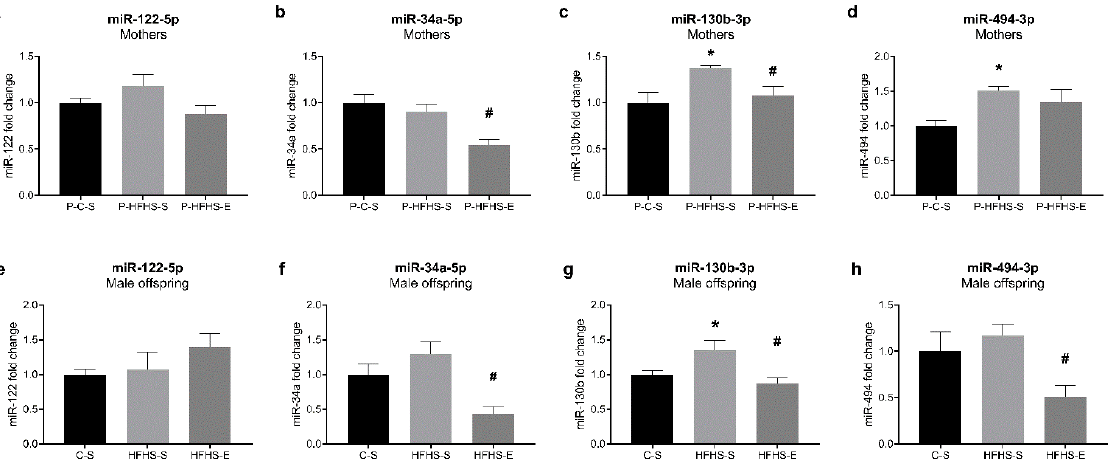
Figure 7. Effects of maternal HFHS and GE on the micro-RNA expression in maternal livers: ( a ) relative expression of miR-122, ( b ) relative expression of miR-34a, ( c ) relative expression of miR-130b, ( d ) relative expression of miR-494; and in offspring: ( e ) relative expression of miR-122, ( f ) relative expression of miR-34a, ( g ) relative expression of miR-130b, ( h ) relative expression of miR-494. GE — gestational exercise; C — mothers fed with control diet; HFHS — mothers fed with high-fat high-sucrose diet; S — sedentary mothers; E — exercised mothers. * vs. P-C-S ( p < 0.05) or vs. C-S ( p < 0.05) in mothers or offspring, respectively. # vs. P-HFHS-S ( p < 0.05) or vs. HFHS-S ( p < 0.05) in mothers or offspring, respectively.